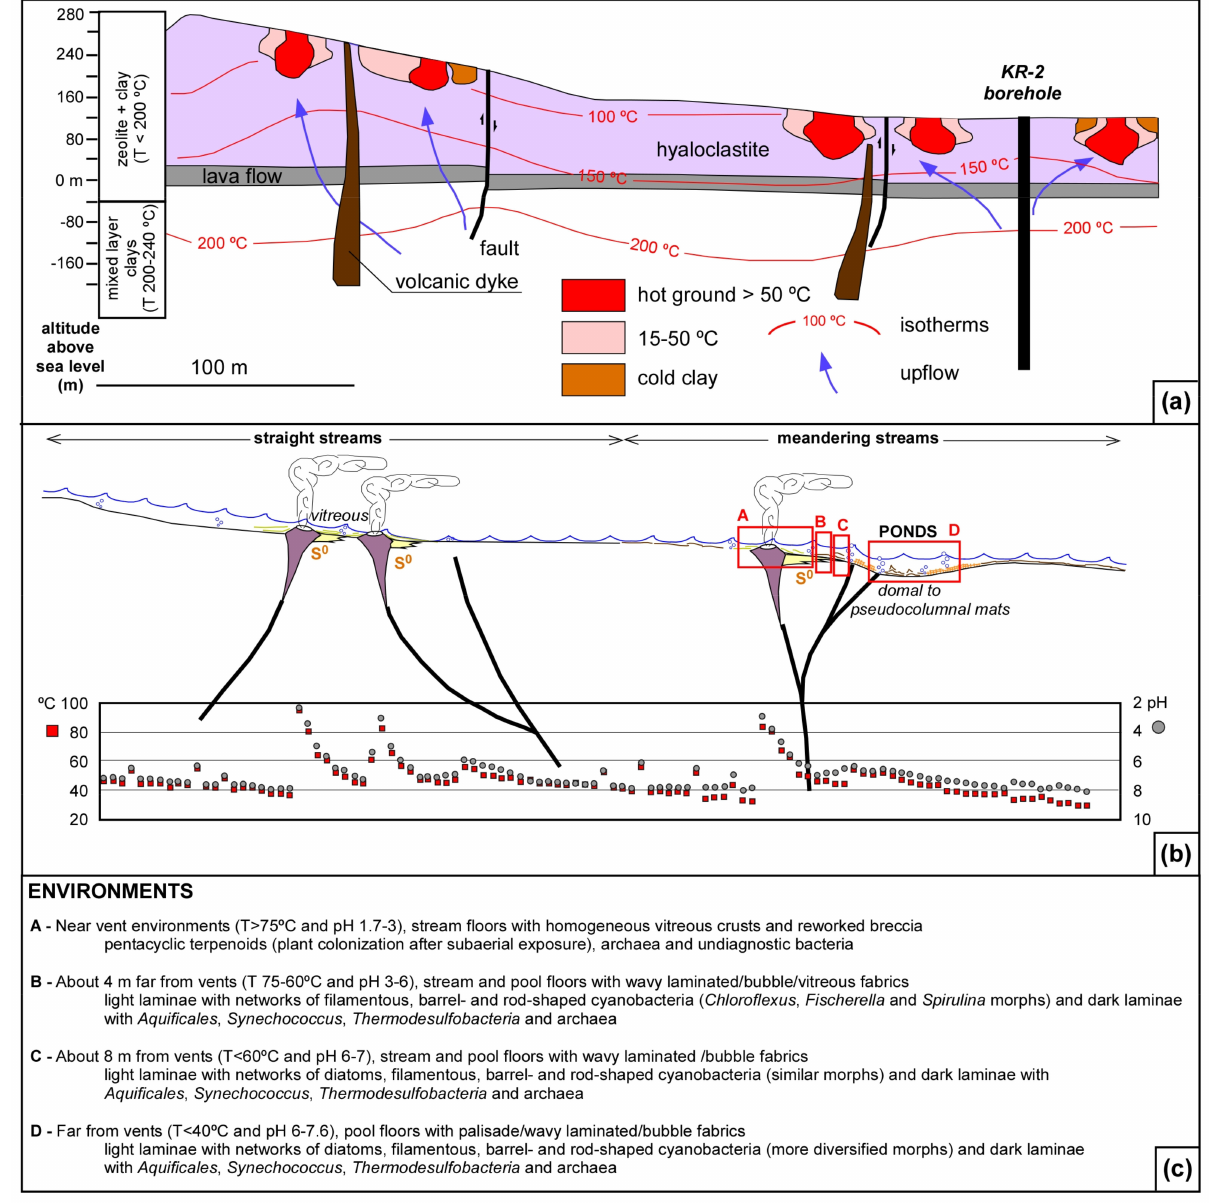
Figure 11. Schematic diagram of the Selt ú n area in the Kr ý suv í k geothermal. ( a ) Geothermal model for the Selt ú n area; modified from [30]. ( b ) Idealized distribution of fabrics described in the text affected by sharp modifications in temperature and pH conditions of surface waters (measured with a Milwaukee Pro + pH meter; 26 August 2016) controlled by setting of dykes and faults; S 0 abundant native sulfur. ( c ) Summary of environments and their microbial sinters at Selt ú